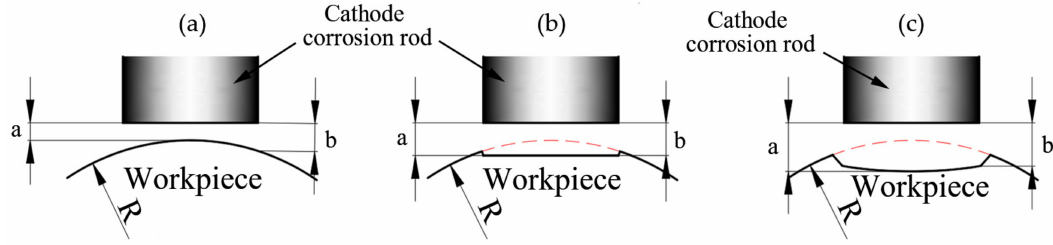
Figure 12. The schematic diagram of electrolytic corrosion process. ( a ) The distance between the center of the cathode corrosion rod and the workpiece is less than that between the edge of the cathode corrosion rod and the workpiece, a < b; ( b ) a = b; ( c ) a >